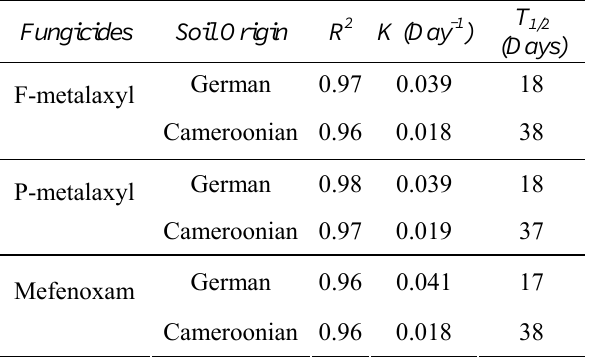
Table 5: Degradation Rate Constants (K); And Half- ) as Derived from the Regression Line from Lives ( T 1/2 the ln (Co/C)/t Plot, as Well as Correlation Coefficients (R 2 ) Values for the Fit for the Degradation of F- metalaxyl and P- metalaxyl and Mefenoxam in German and Cameroonian Soils. Enantioselective Degradation of Racemic Metalaxyl in